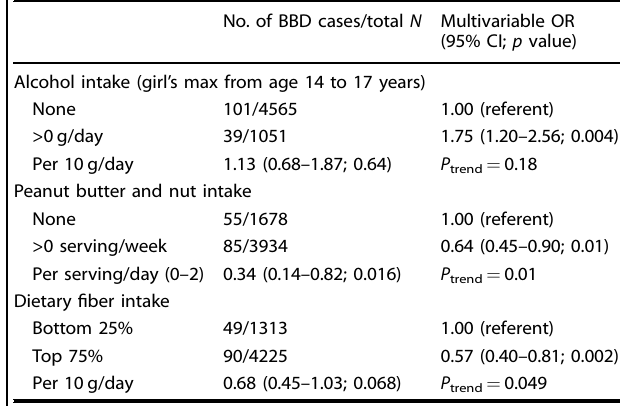
Table 2. Ages 14 – 17-year intakes of alcohol, peanut butter/nuts, and dietary fi ber in separate multivariable a logistic models of risk for biopsy-con fi rmed BBD (reported at age ≥ 18 years).